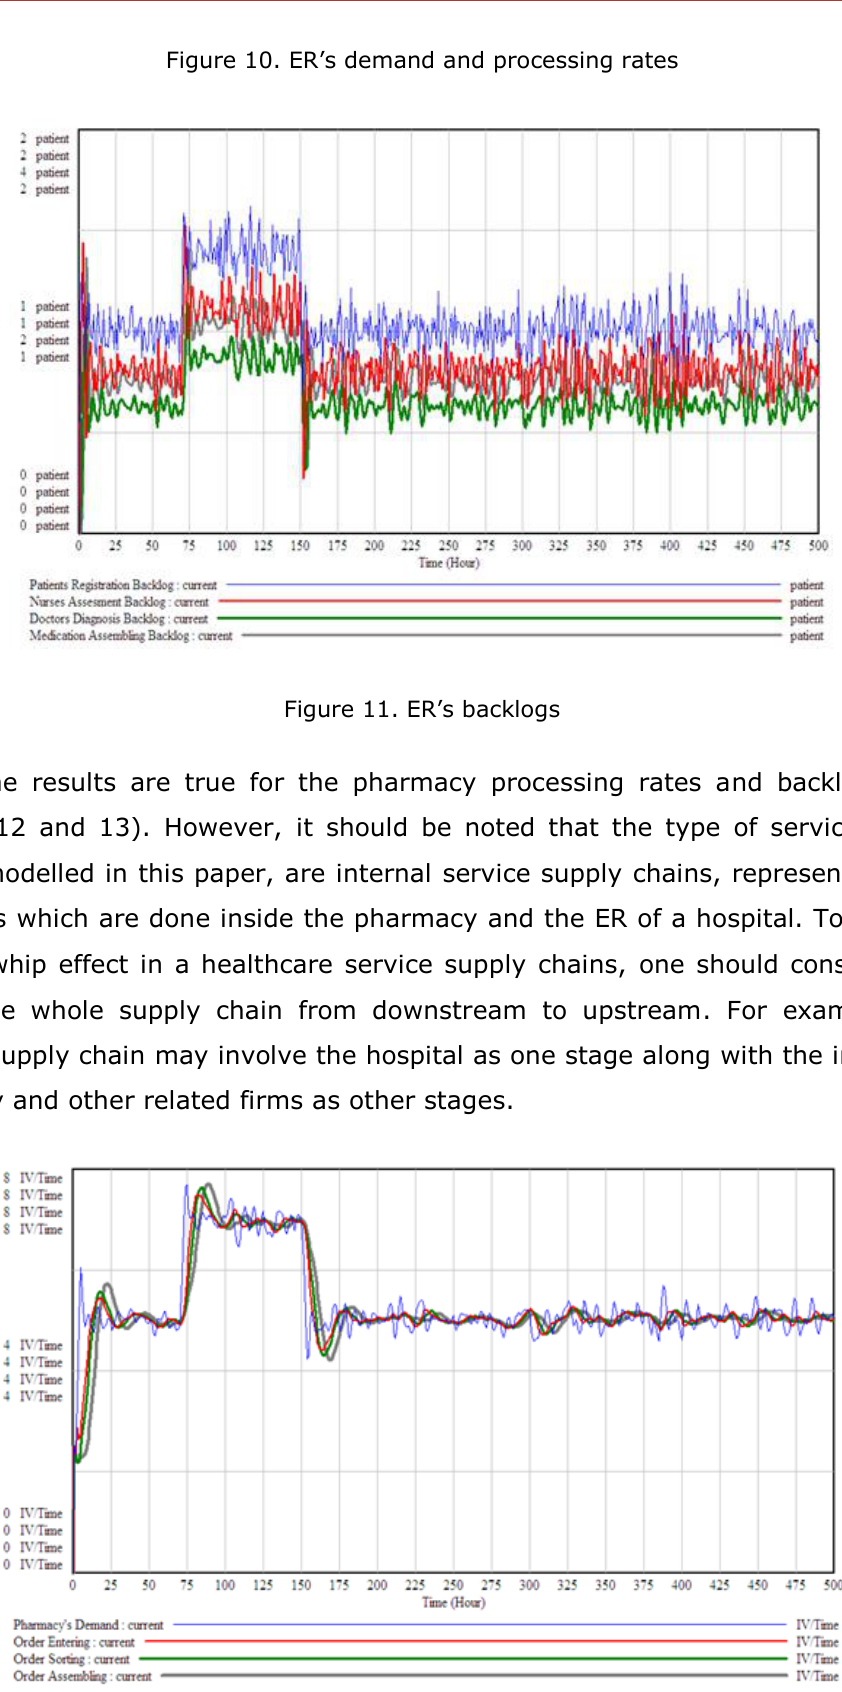
Figure 10. ER’s demand and processing rates